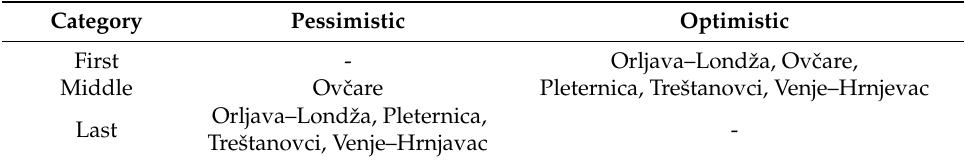
Table 8. Results of ELECTRE TRI for Scenario 1.